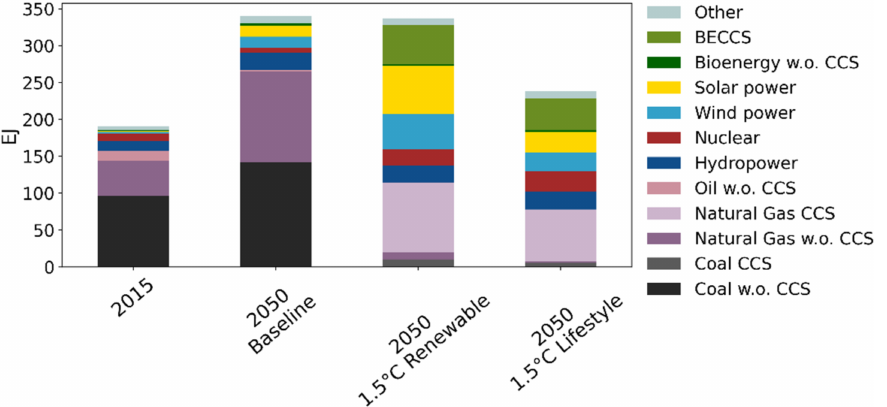
Figure 3. The global primary energy mix of power